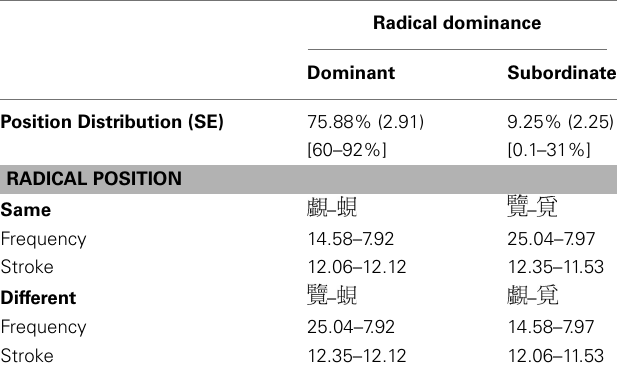
Table 1 | Examples of pairs of prime (left) and target (right) characters with mean dominance, frequency (per million), and stroke number in each experimental